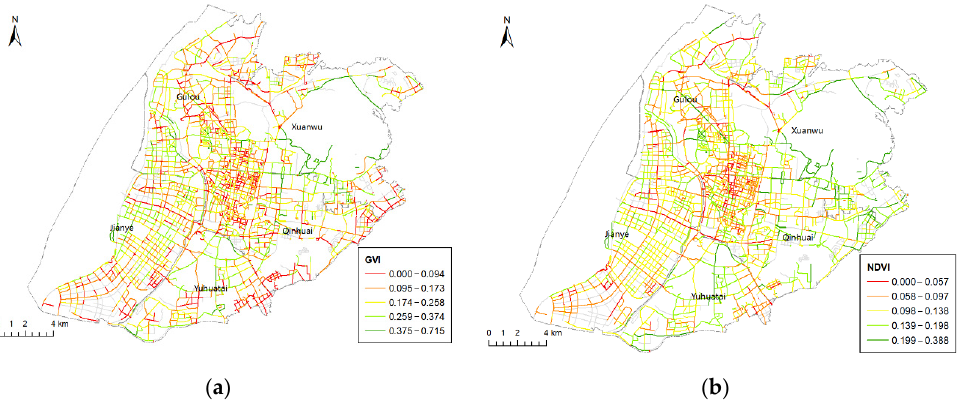
Figure 10. Comparison of the street–level GVI and Normalized Difference Vegetation Index (NDVI). Levels were both classified by the natural break method. ( a ) Street–level GVI distribution. ( b ) Street–level NDVI distribution. Table 6. Spearman correlations between the GVI and Normalized Difference Vegetation Index (NDVI) in each urban district.